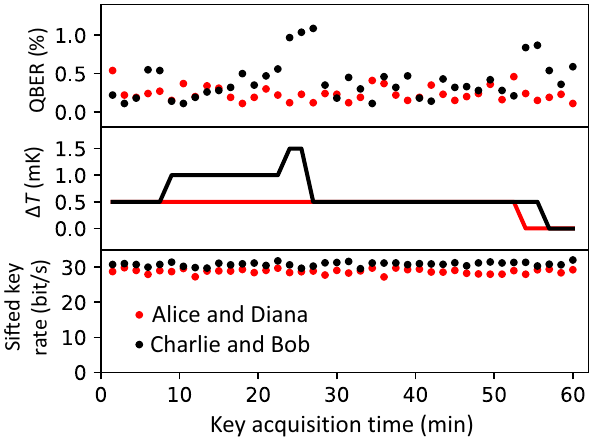
FIG. 4. A simultaneous key exchange for Alice and Diana (red) and Charlie and Bob (black) without fiber spools and with a mean photon-pair number per pulse μ below 1 × 10 -3 demonstrat- ing low QBERs. The temperature change (cid:6) T shows adjustments made at Alice’s and Bob’s receivers to minimize the error rate. Each data point is obtained from one run of 90 s. The average QBER is 0.24% for Alice and Diana and 0.41% for Charlie and Bob,